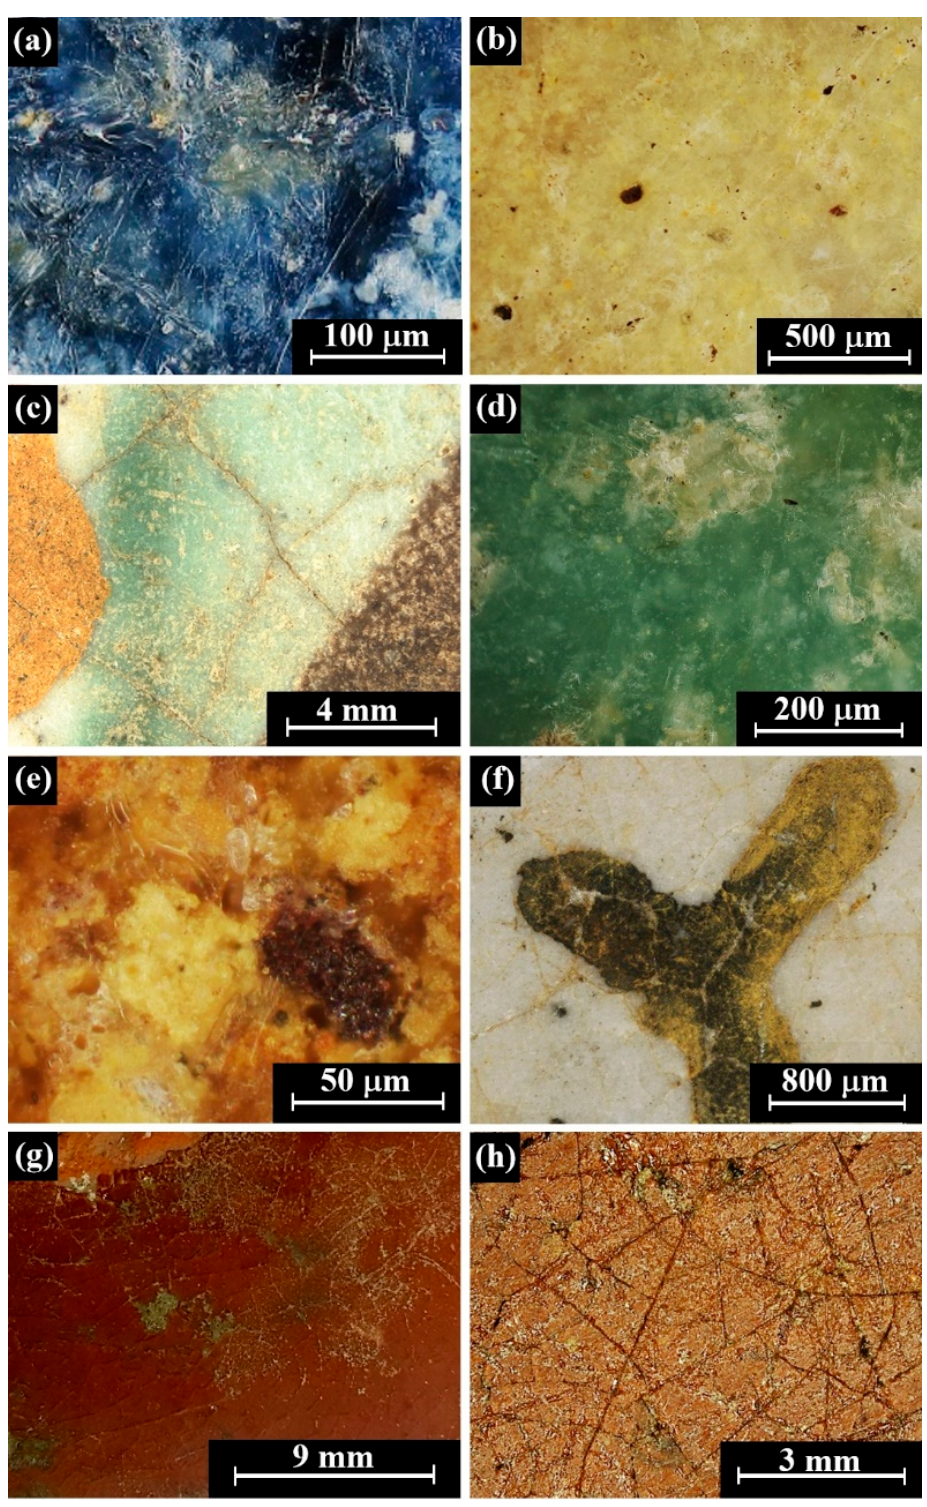
Figure 3. Images of tiles. Tile no. 334, Type A: ( a ) area of blue pigment; ( b ) area of yellow pigment; ( c ) orange, green, and brown decoration on top of white glaze matrix; ( d ) green decoration on top of white glaze matrix; ( e ) area of orange pigment; tile no. 339, Type A: ( f ) olive-green decoration on top of white glaze matrix; tile no. 328, Type B: ( g ) general view; and tile no. 328, and Type B: ( h ) area of brown pigment matrix covered with transparent brown glaze (photos: H. Kravits and M. Cohen).